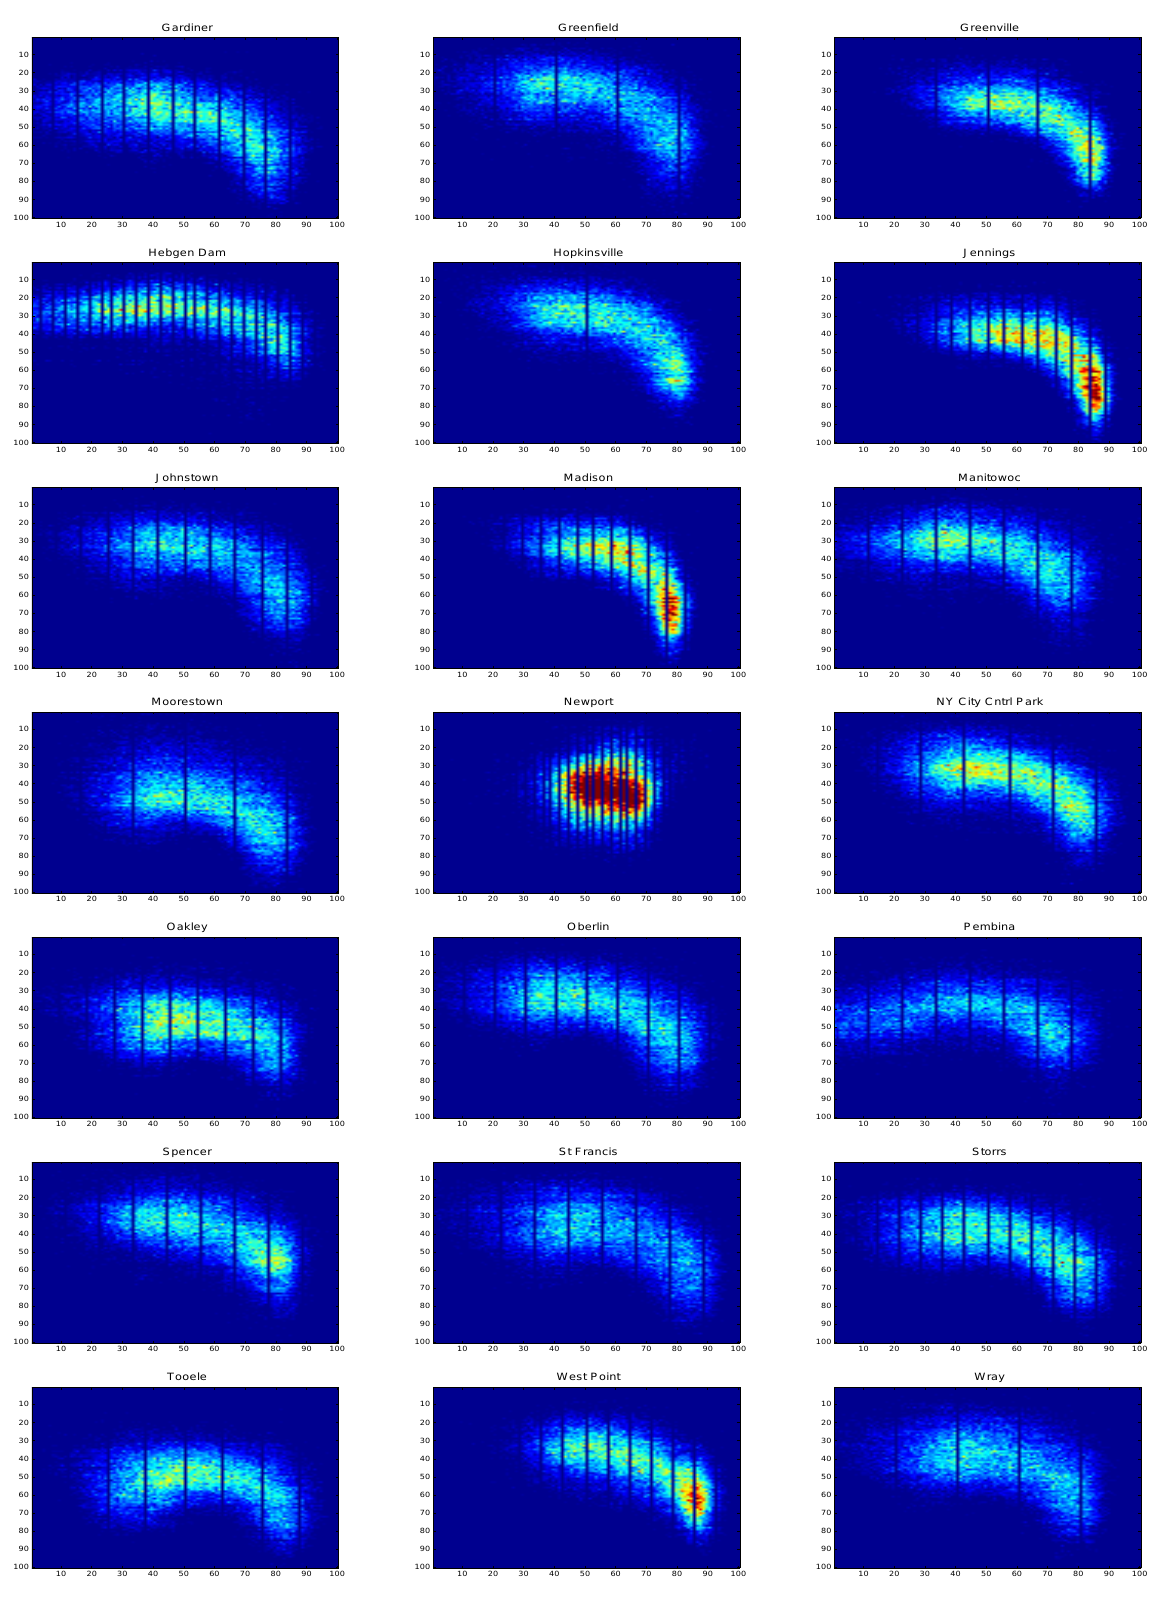
Fig. 13. Fig. 14. Phase planes for 42 sites across USA (continued).